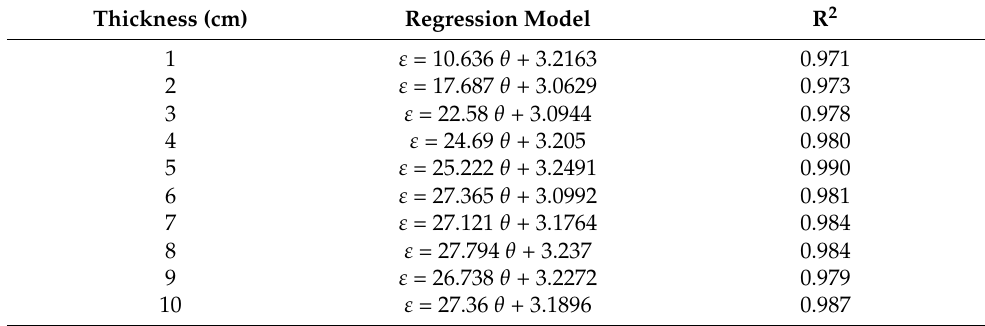
Table 5. Mathematical dependences between sample moisture (cm 3 /cm 3 ) and apparent permittivity values read by Sensor B for particle sample